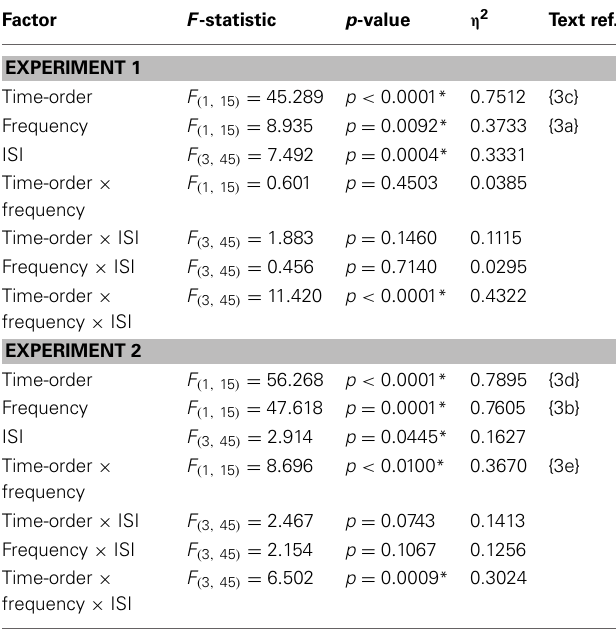
Table 3 | Accuracy (proportion correct) statistics of the time-order × frequency × ISI repeated measures ANOVA.